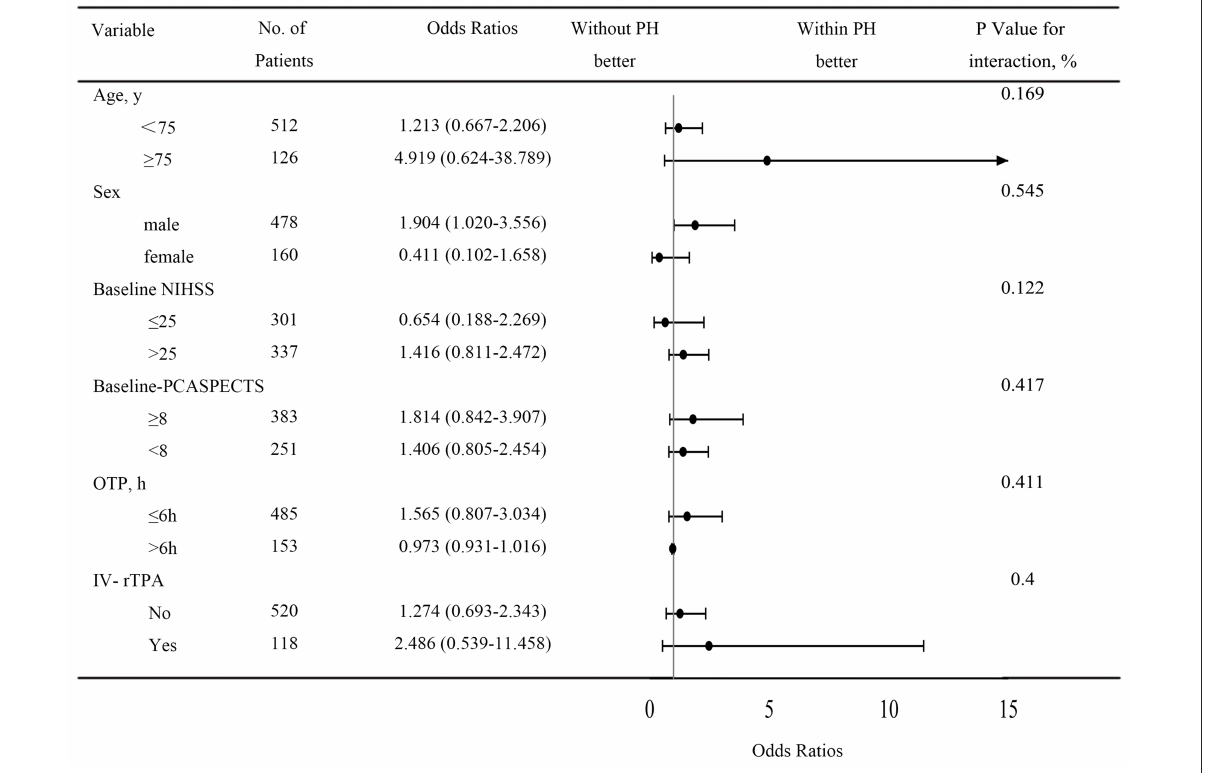
FIGURE2 Subgroup analysis of PH after intra-arterial tirofiban treatment. Intra-arterial tirofiban administration did not increase the risks of PH. CI, confidence interval; OR, relative risk; NIHSS, National Institute of Health Stroke Scale; PCASPECTS, Posterior circulation Alberta Stroke Program